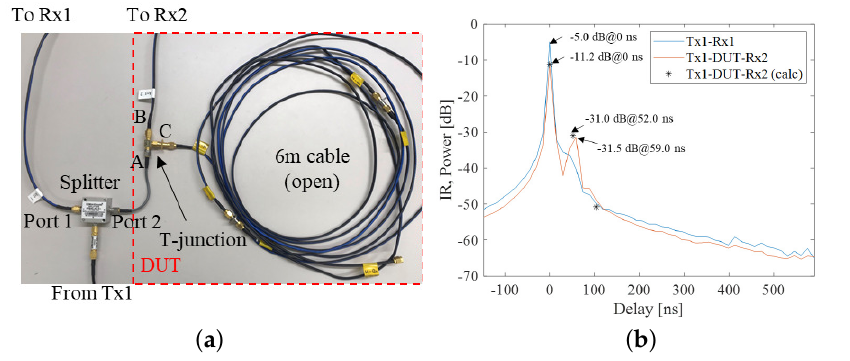
Figure 7. DUT test. ( a ) DUT test setup. ( b ) DUT test result.